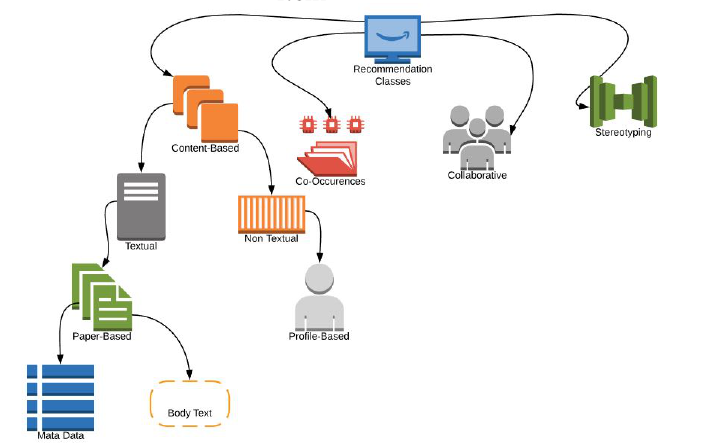
Figure 1. Recommendation Classes